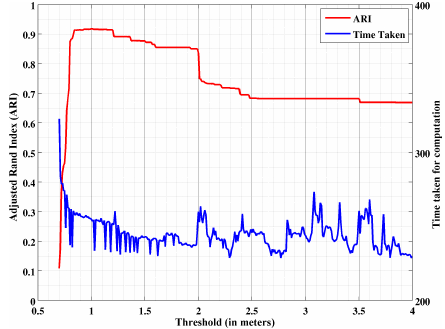
Figure 4: ARI Performance graphs for DBSCAN